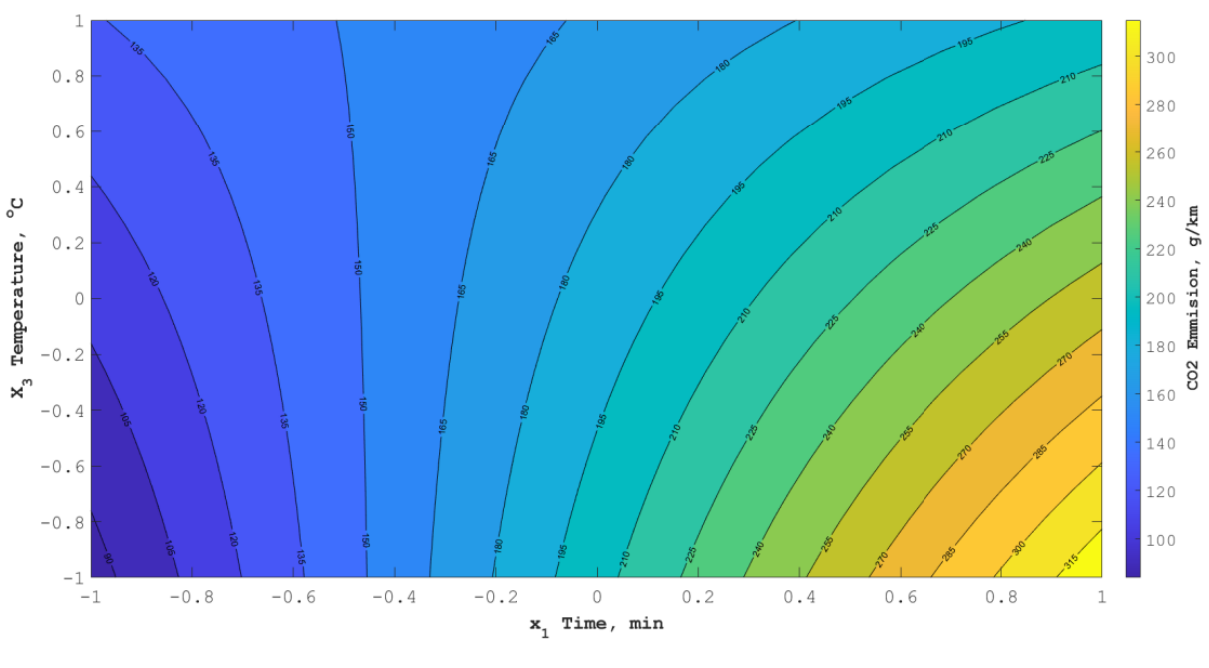
Figure 13. Change in CO 2 emissions depending on the variability of factors x 2 and x 3 for a vehicle (EV) moving for 10 min (x 1 = 1).